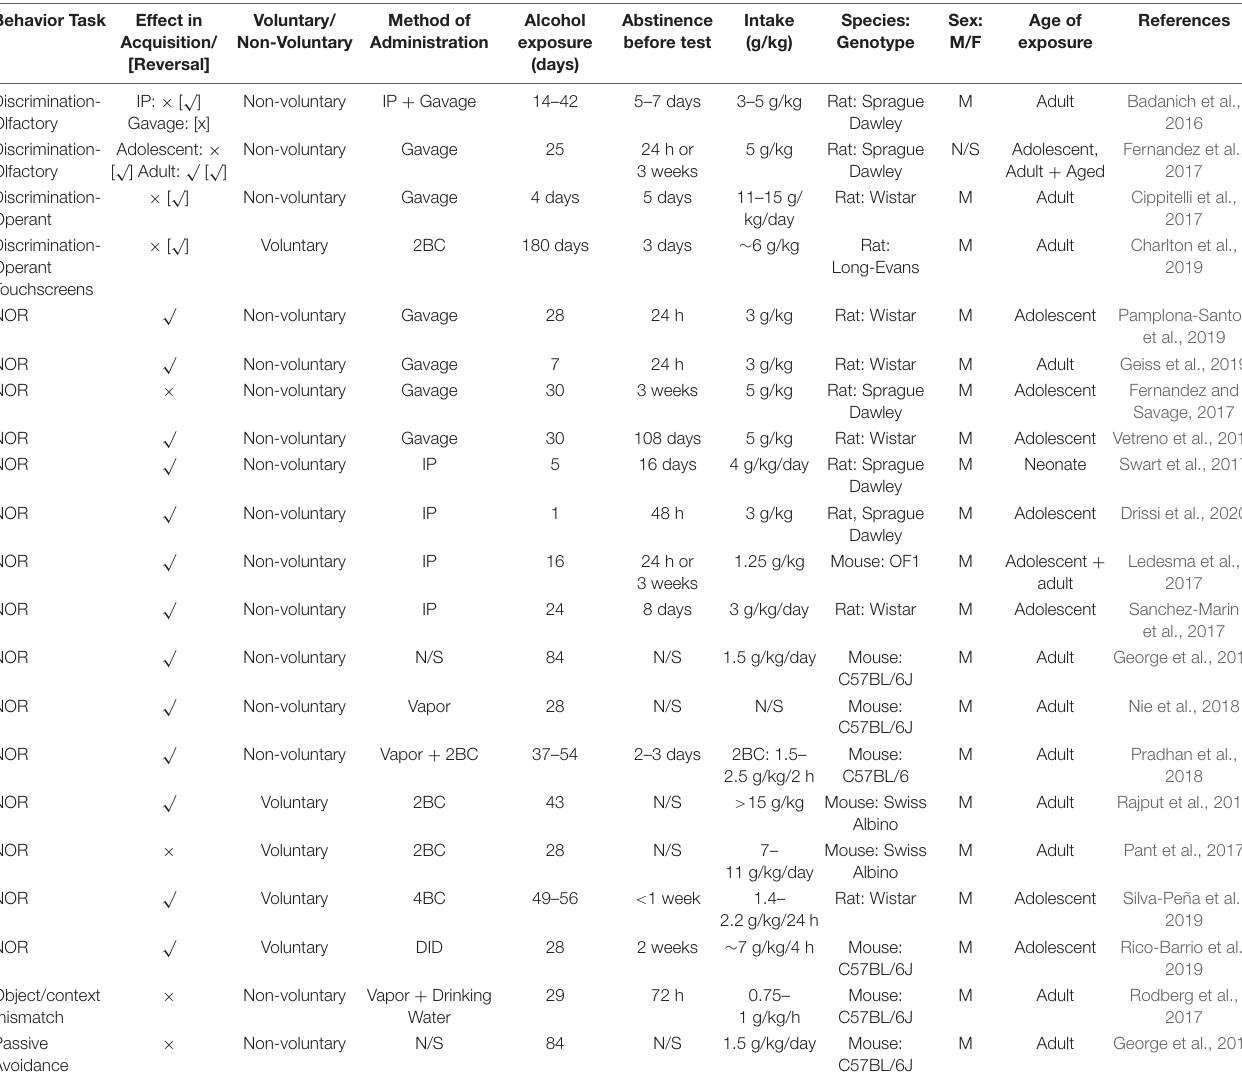
TABLE 2 | Working memory and discrimination summary from reviewed studies outlining behavior task, effect, methodology and subjects. Behavior